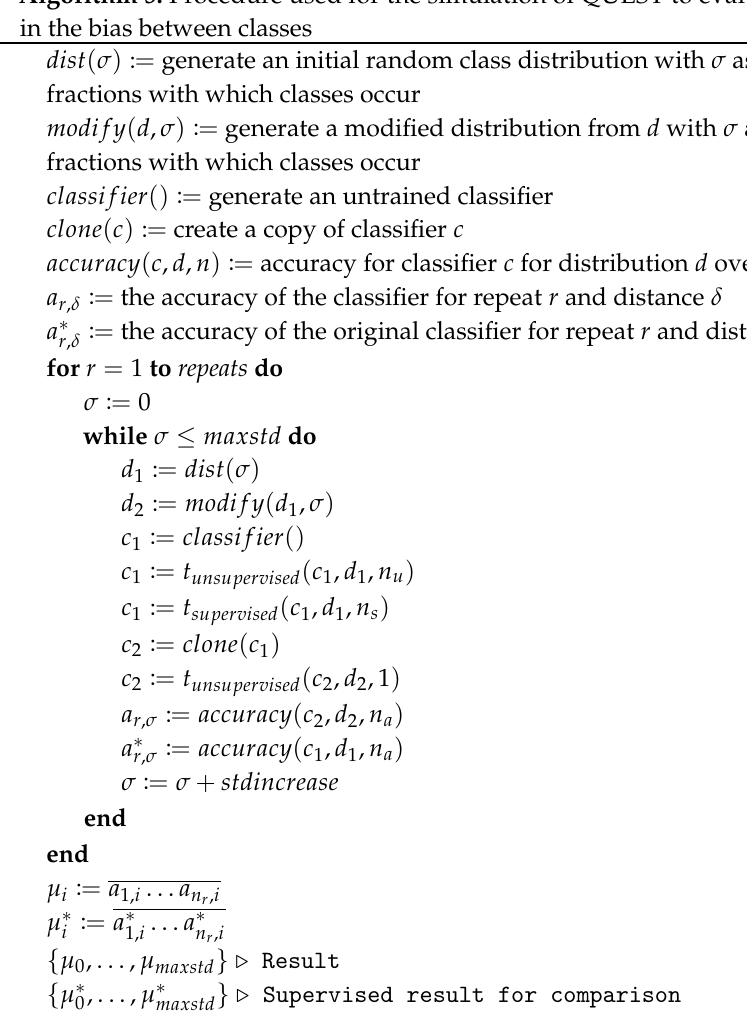
Algorithm 5: Procedure used for the simulation of QUEST to evaluate the effect of variations in the bias between